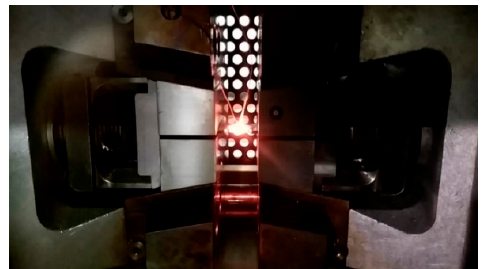
Figure 6. Samples for testing on a Gleeble 3500 device and a tensile test after simulation: ( a ) dimensions of the test sample (unit: mm); ( b ) view of the test sample with a thermocouple welded on it.